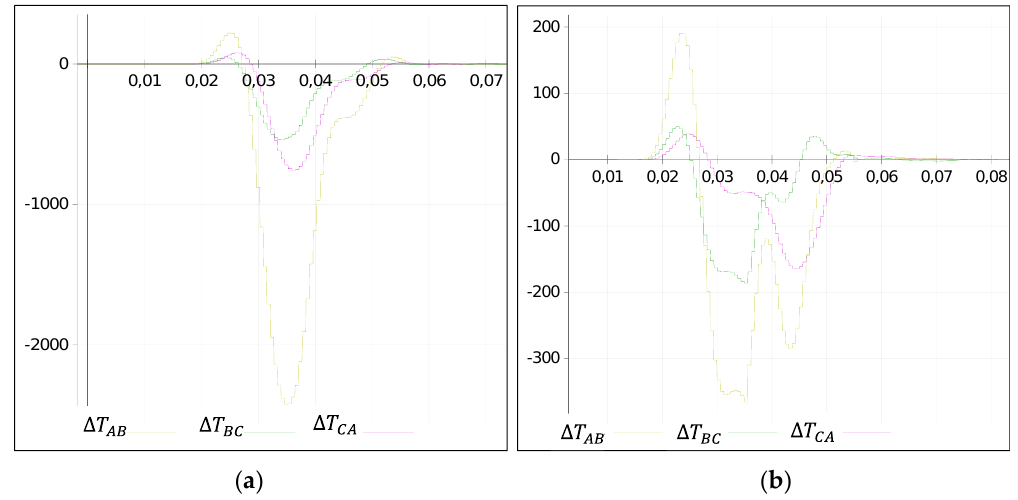
Figure 8. Instantaneous values of scalar products based on superimposed quantities theory for ABG fault when current contribution comes from SG ( a ) or Type 4 WT ( b ).